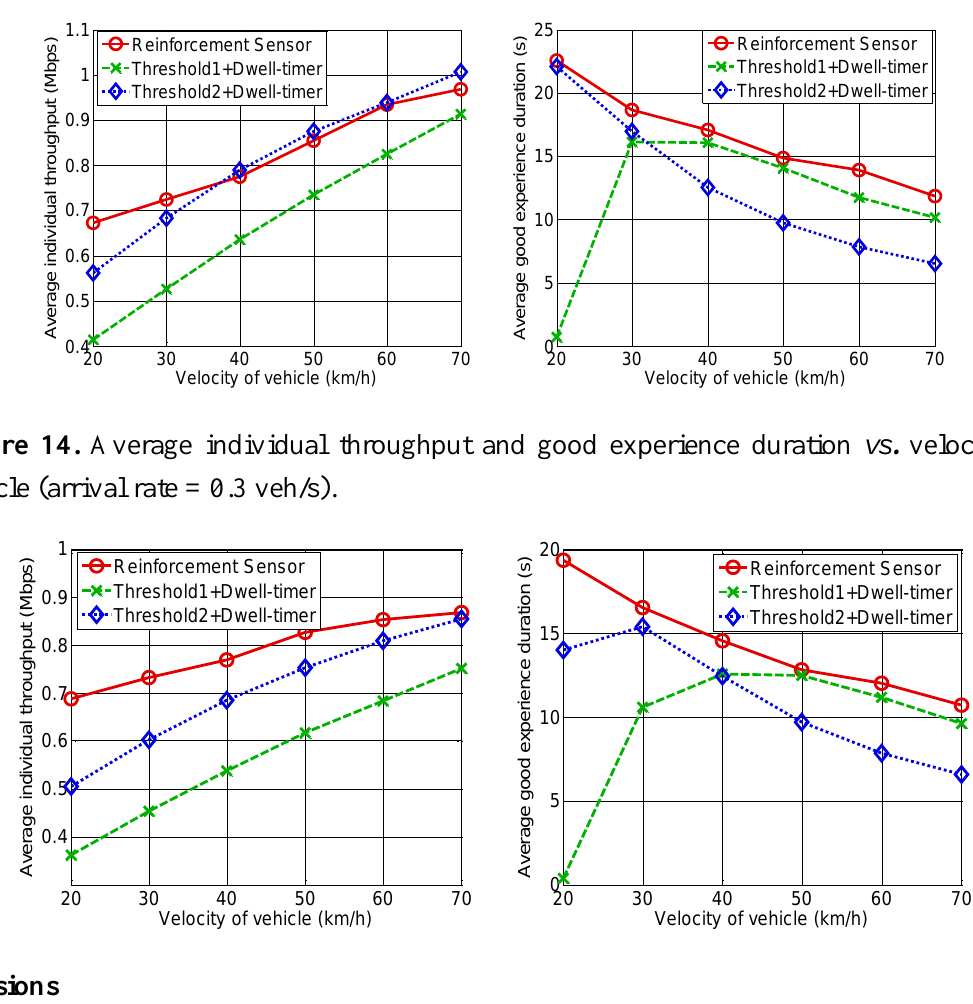
Figure 13. Average individual throughput and good experience duration vs. velocity of vehicle (arrival rate = 0.4 veh/s).